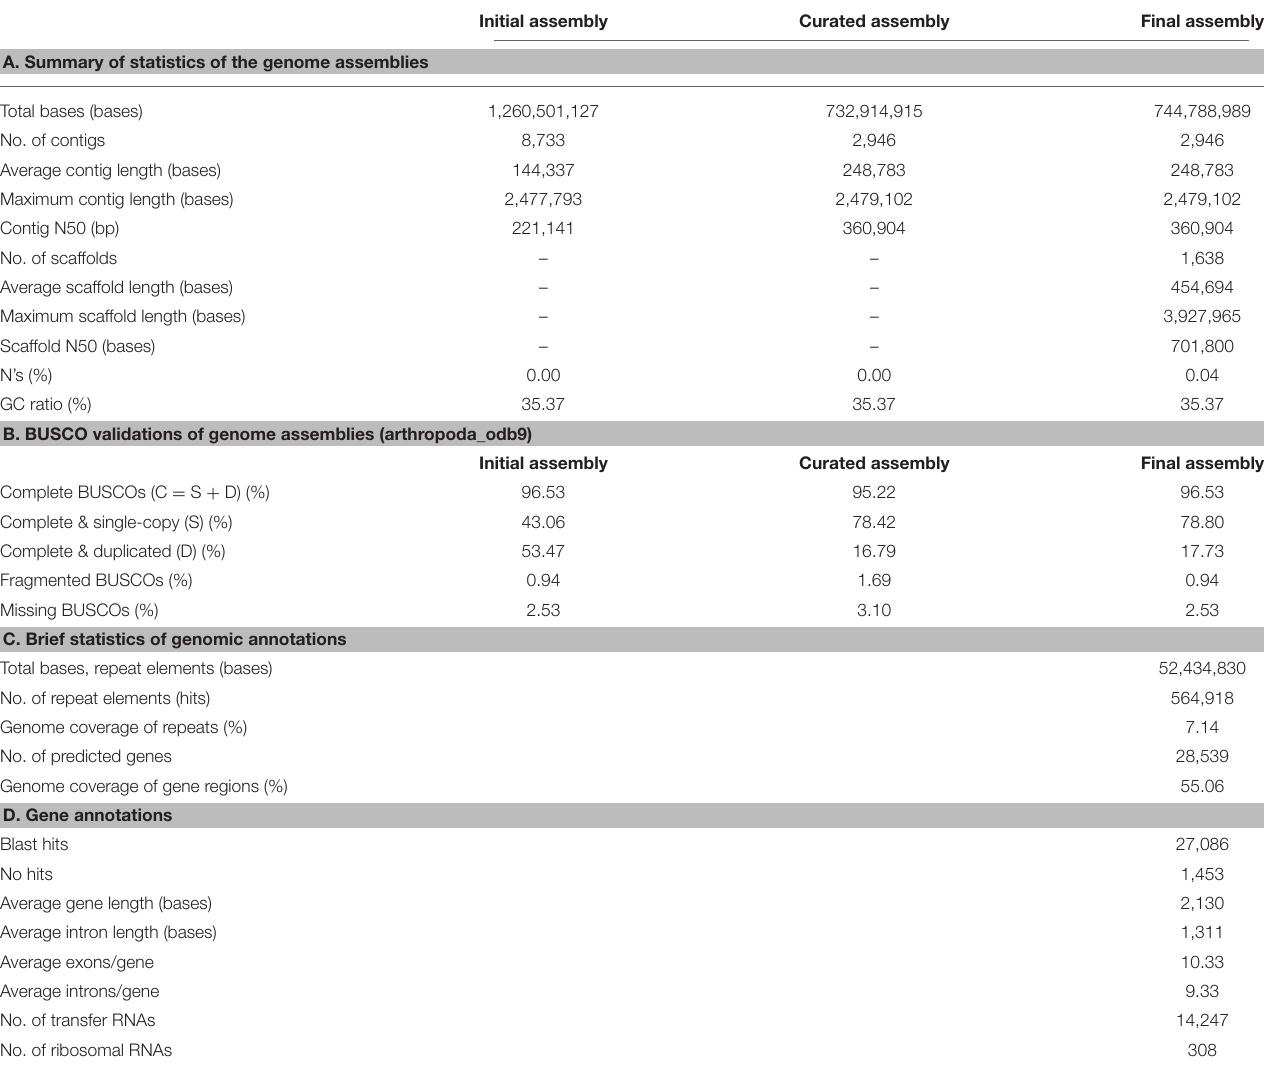
TABLE 1 | Summary of genome assembly and annotation of Nymphon striatum